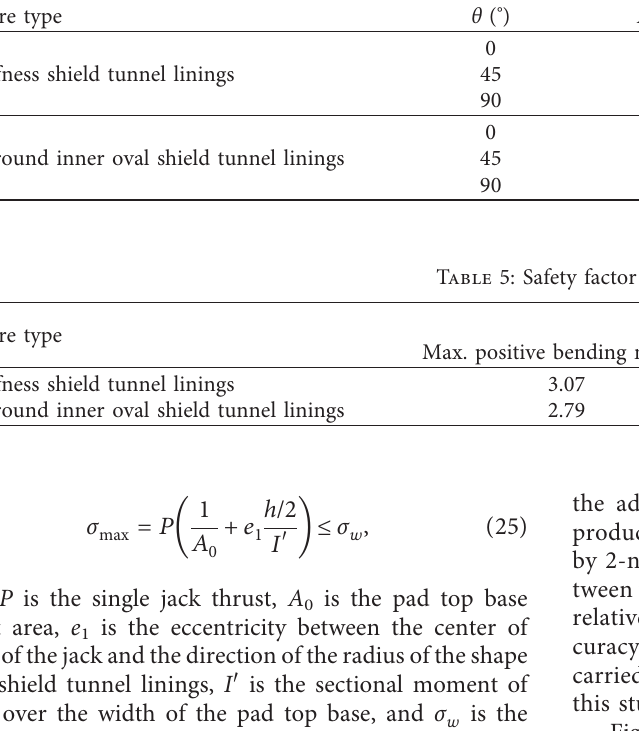
Table 4: Dangerous sections of the structure and their internal forces.